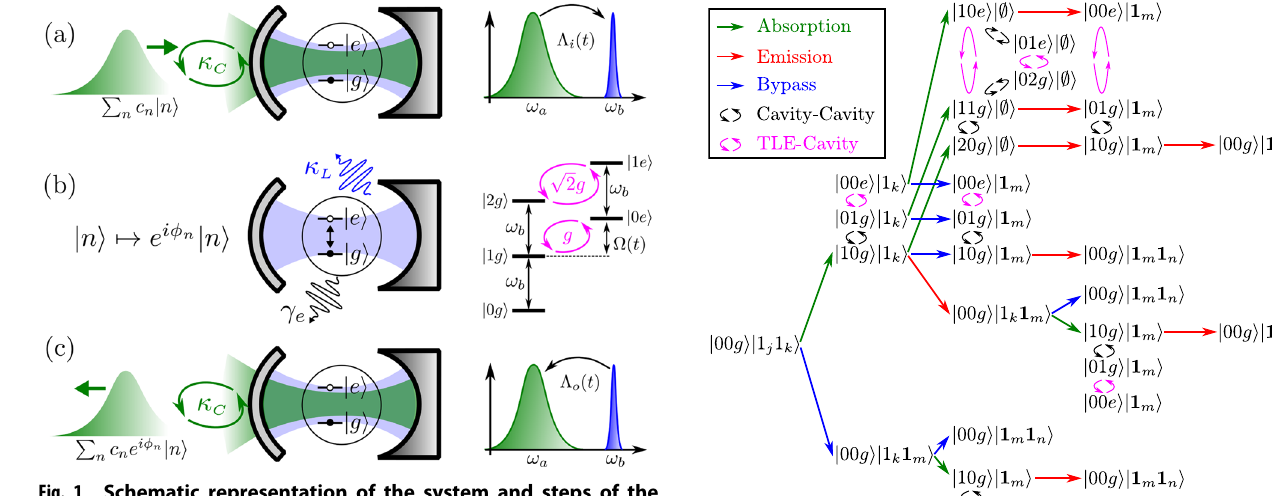
Fig. 1 Schematic representation of the system and steps of the P gate protocol. a An incoming wave packet (green) in state c n n j i is coupled into a cavity mode ^ a (also green). Mode ^ a is coupled to a ^ b (blue) via an external control fi eld Λ i ( t ) as second available mode Fig. 2 All input-output paths for two incident photons. Each depicted in the spectrum diagram on the right. This coupling ^ photon may be absorbed (green) and re-emitted (red) or bypass the b . enables the capture of the incoming ω a wave packet into mode cavity by re fl ecting off of the left mirror in Fig. 1a at time t m . Inside ^ b Mode b is coupled to a two-level emitter (TLE) at vacuum rate g . the cavity, the photons may couple between the cavity modes We control the detuning of the TLE through an external fi eld ^ b (black) or between the TLE and mode described by Ω ( t ). As seen in the energy-level diagram, the cavity- ^ b , which TLE coupling depends on the number of photons in mode enables the depicted photon-number-dependent transformation. c Controlled release using a second control pulse, Λ o ( t ). The state of the outgoing packet has undergone phase changes conditioned on the number of photons.